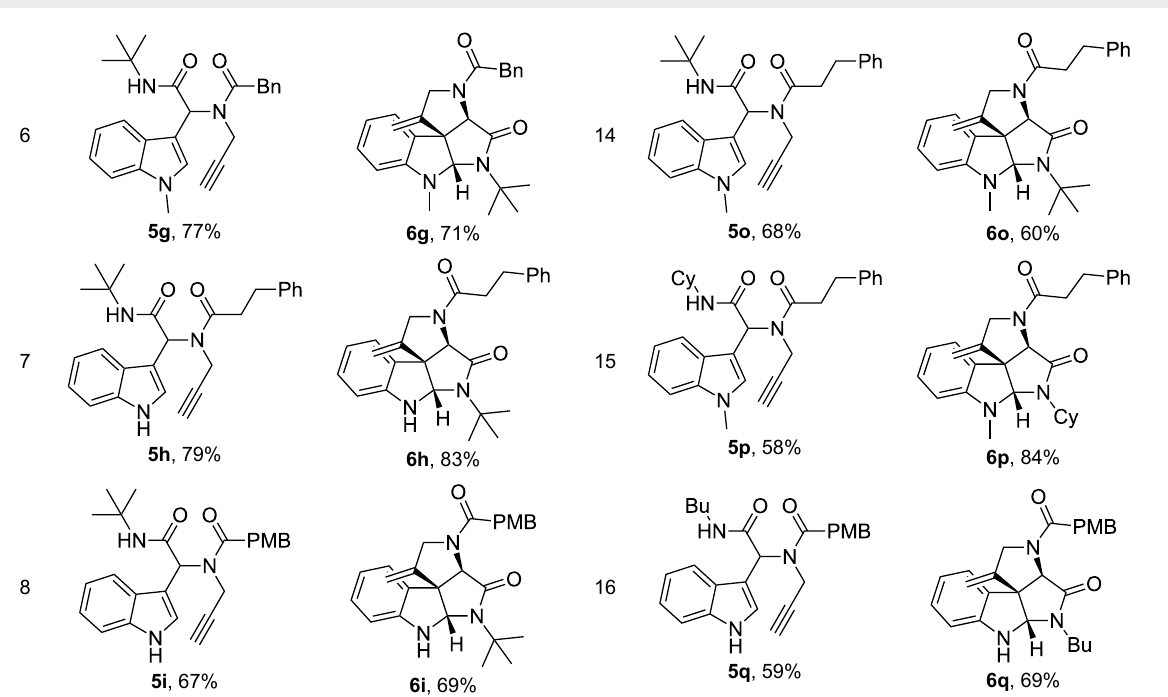
Table 2: Scope and limitations of intramolecular domino cyclization. a